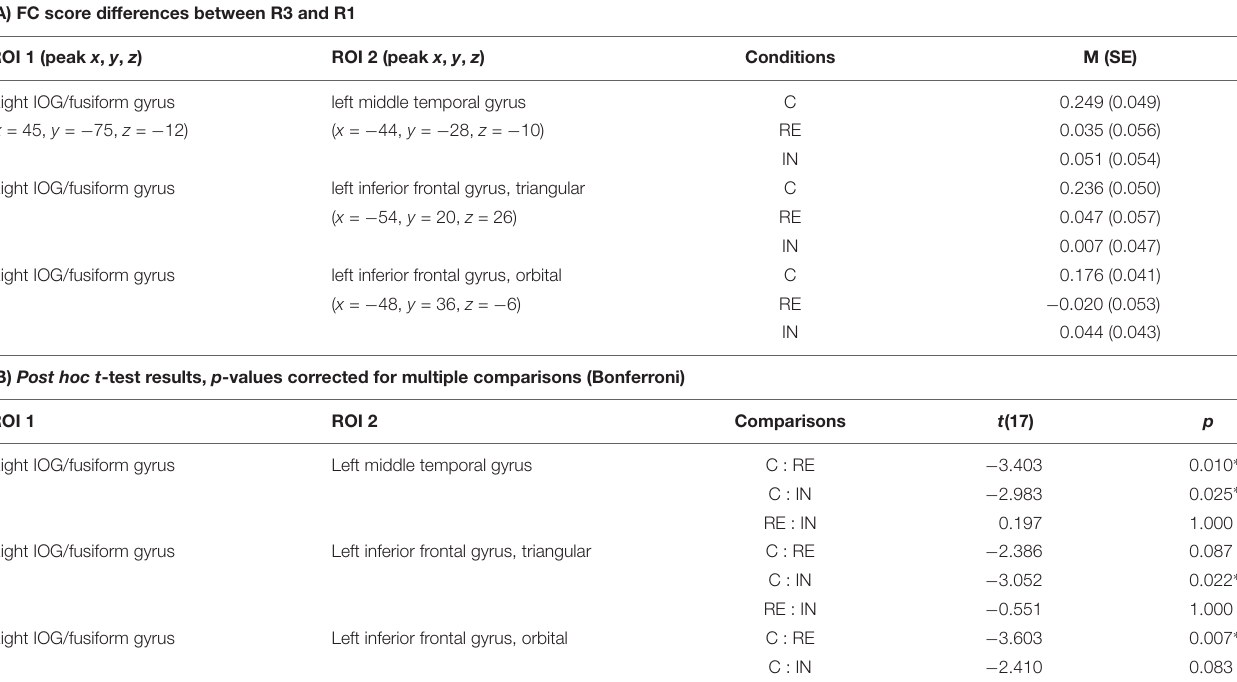
TABLE 2 | Changes in functional connectivity between R1 and R3.